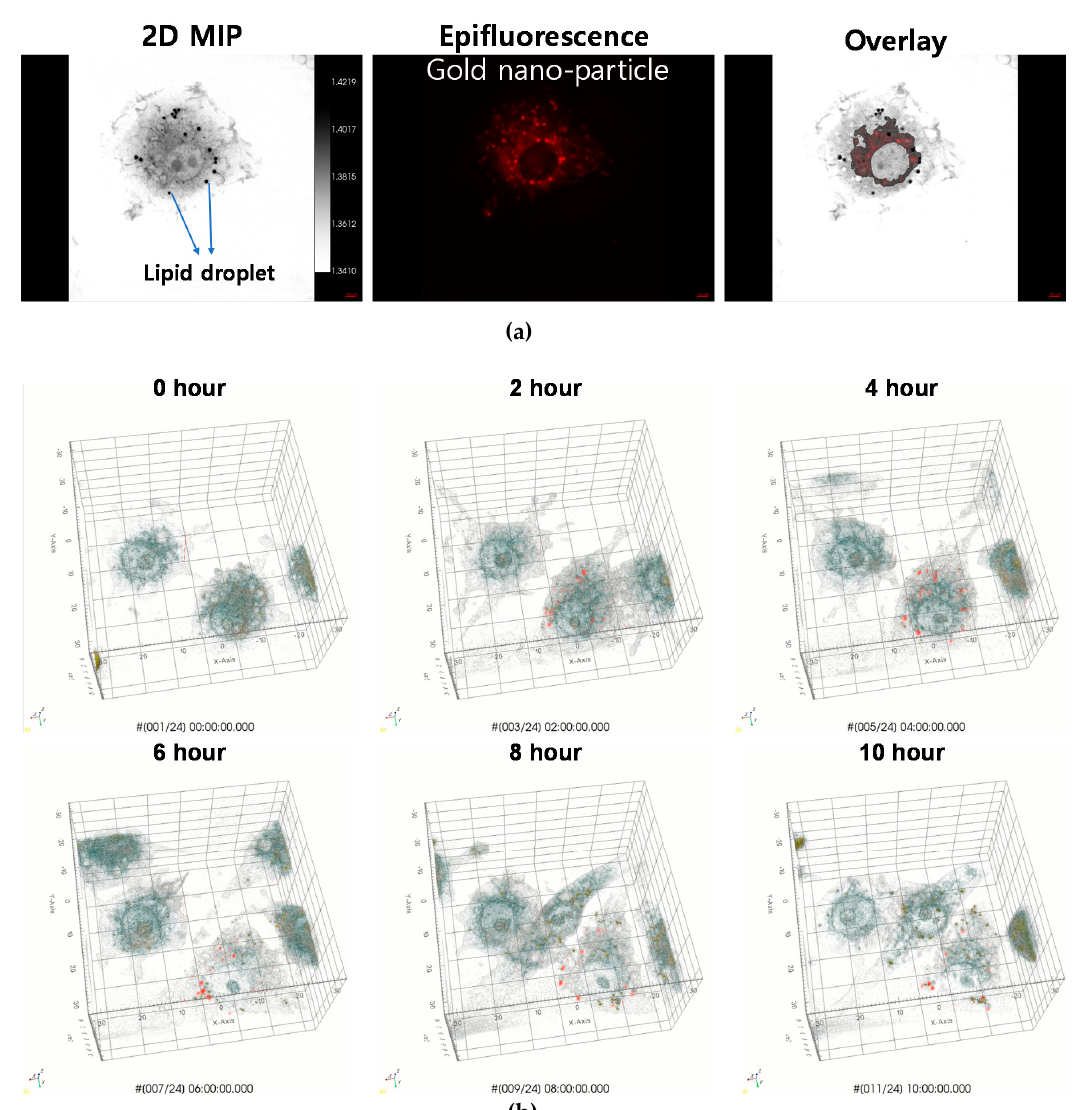
Figure 2. ( a ) The epifluorescence image of AuNP-loaded macrophage cells. Black dots and red epifluorescence indicate the lipid droplets and AuNPs, respectively, on a macrophage cell. (Lipid droplet RI value > 1.38). ( b ) Cellular uptake and release of AuNPs in macrophage cells. Cells were continuously exposed to AuNPs for 24 h, and an hourly time-lapse image was generated. After 5 h, the AuNP intensity showed the same result. (the grid lines show each plane of the x, y, and z axis and scale unit is um).